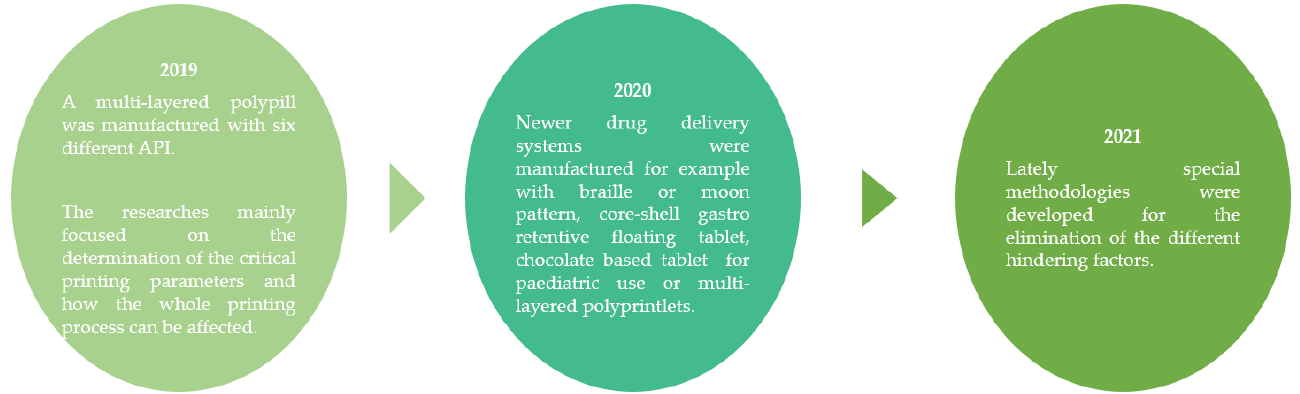
Figure 11. Flow chart of the described tablet manufacturing methods and main breakthroughs since 2019.